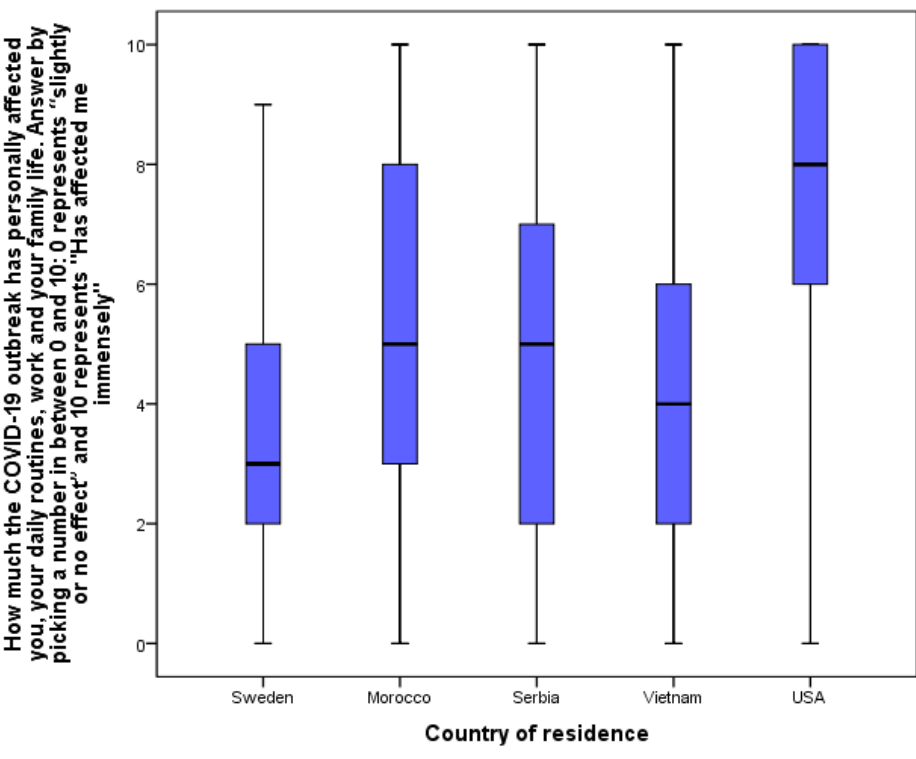
Figure 2. The impact of the COVID-19 outbreak on adolescents according to their country of residence. Number of respondents: N Sweden = 1584; N Morocco = 441; N Serbia = 1079; N Vietnamn = 1452; N USA = 321.